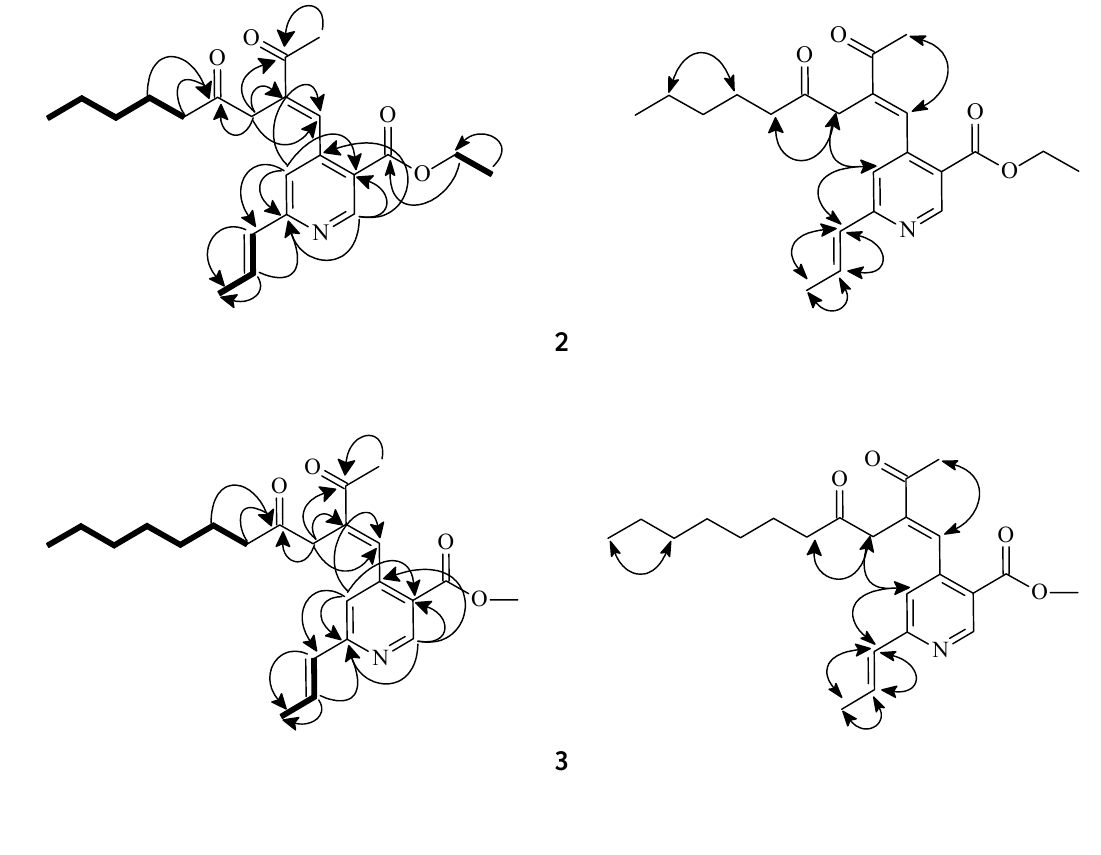
Figure 2. Key COSY ( ▬ ), NOESY (H ↔ H), and HMBC (H → C) correlations of 2–4